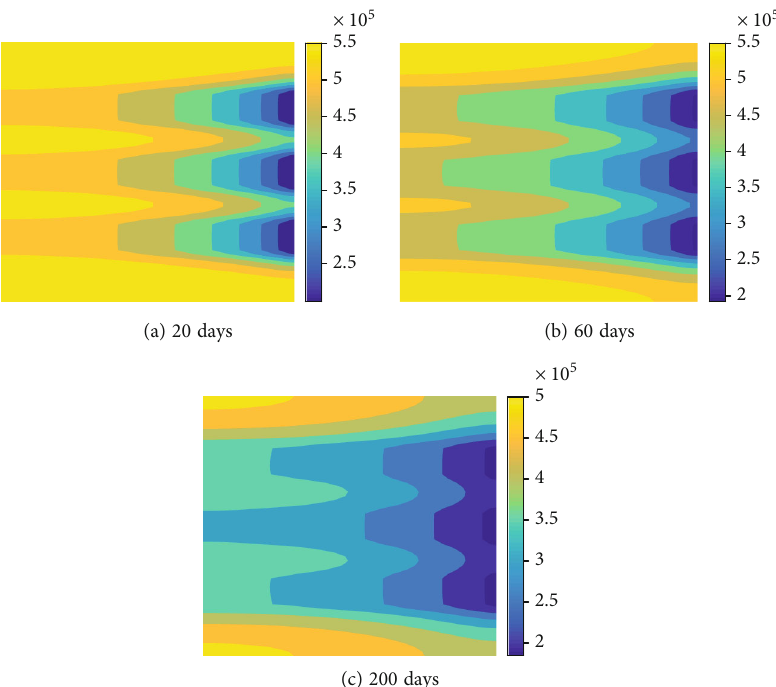
Figure 15: Pressure distributions in example 2 with c